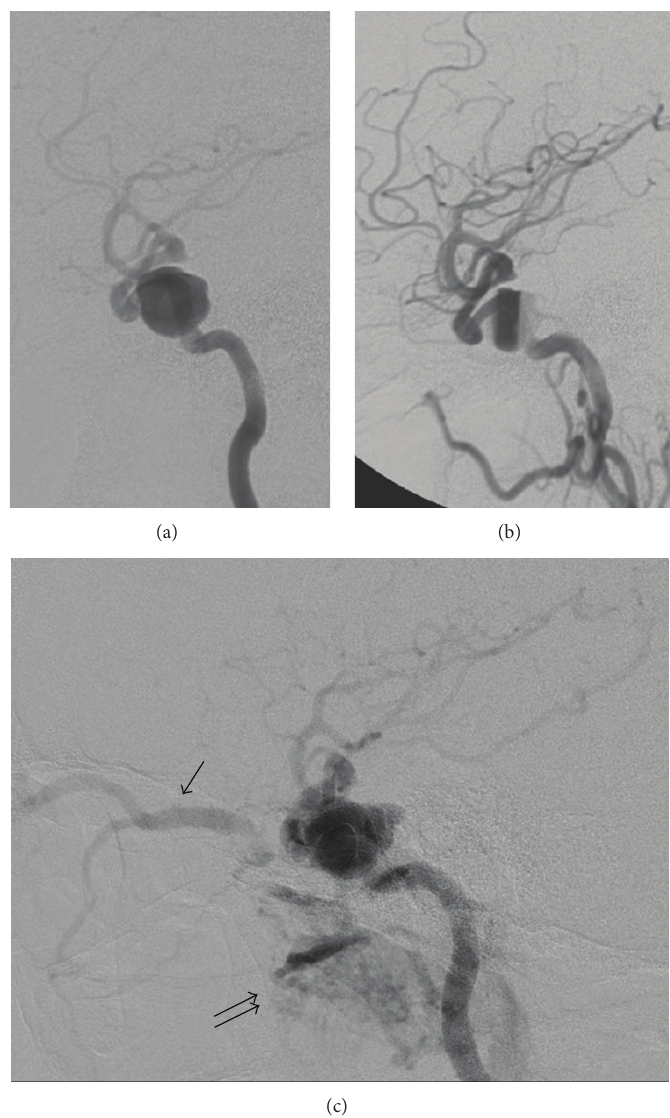
Figure 4: Arterial phase lateral view angiograms of a right cavernous internal carotid artery aneurysm, (a) initial pretreatment angiogram, (b) immediate contrast stasis within the aneurysm at the end of deployment of two telescoping pipeline embolization devices, and (c) carotid cavernous fistula on angiogram at 4 months after treatment done for symptoms of right eye pain, swelling, and vision loss. Note filling of aneurysm sac in (c) as well as venous drainage in the enlarged superior ophthalmic vein (arrow) and the pterygoid venous plexus (double arrows).